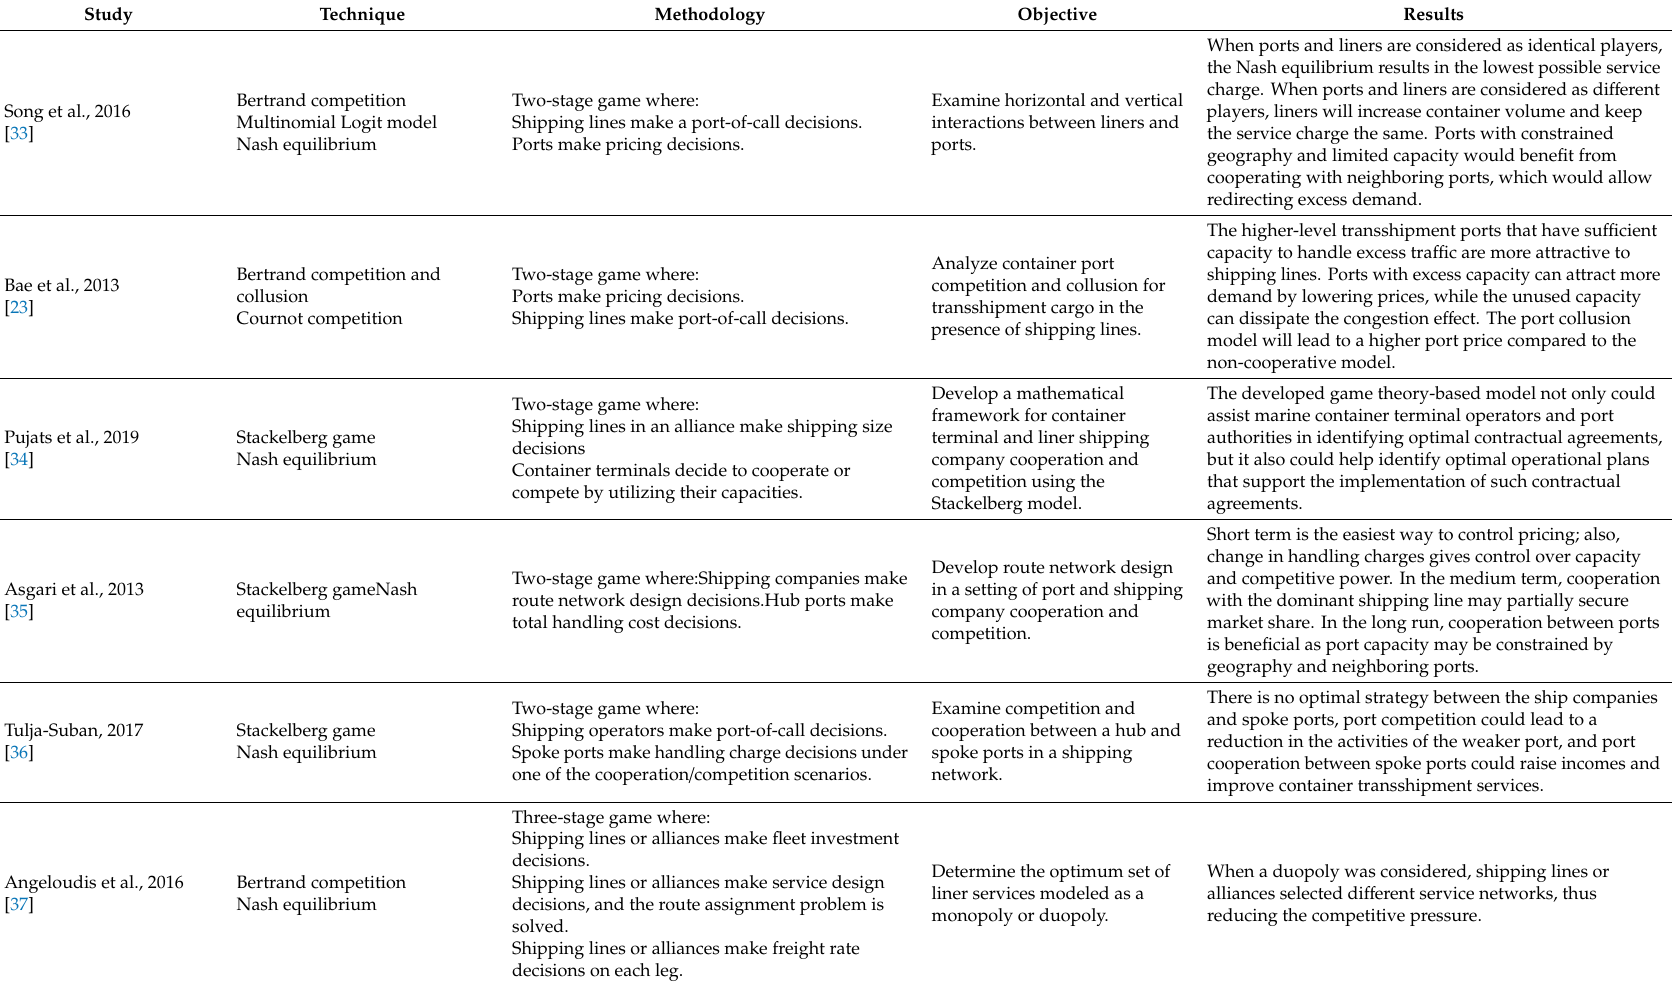
Table 4. Summary of Port and Shipping Line Competition and